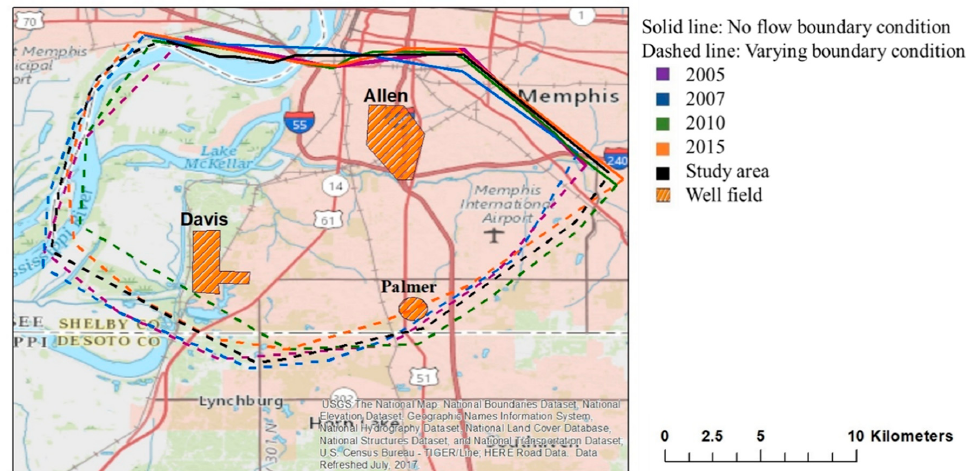
Figure 4. The no-flow boundary condition (solid lines) and temporarily varying boundary conditions (dashed lines) of the Memphis aquifer for the years of 2005, 2007, 2010, and 2015. The black line shows the estimated extent of the study area.